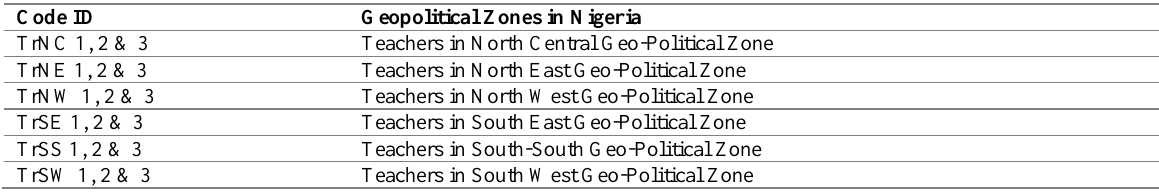
Table 3: Geopolitical Zones in Nigeria